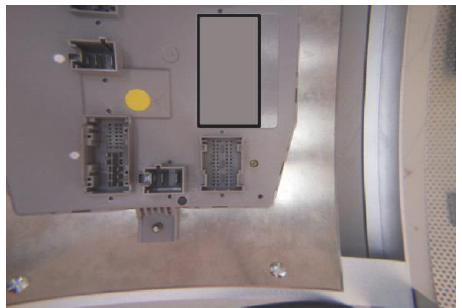
Figure 10. Initial image taken over by a camera.